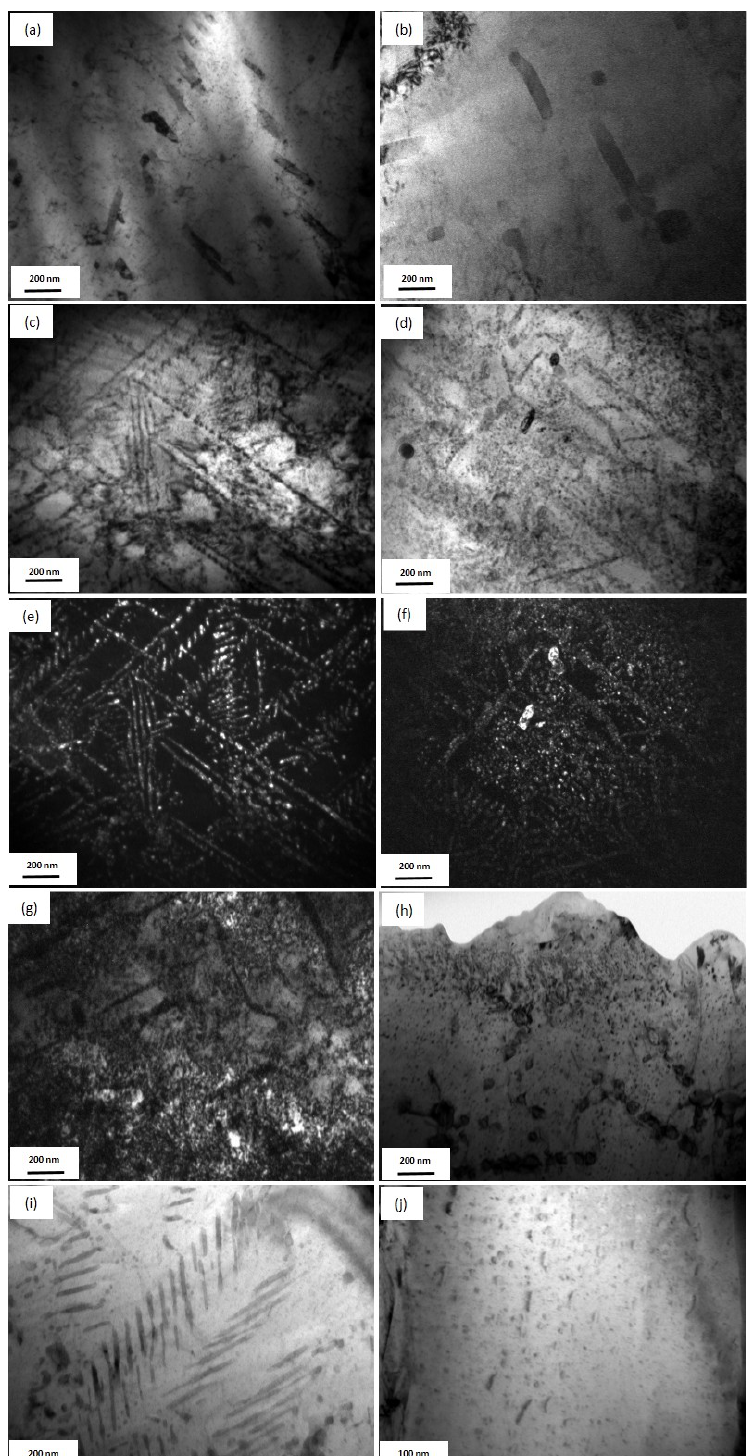
Figure 4. TEM images showing Ag precipitates in the Cu matrix at various temperatures for 4 h. Fe-free alloy: ( a ) as-solid-solution, ( c ) 450 °C and (e) dark field image of 450 °C, ( g ) 500 °C, ( i ) 550 °C; Fe-doping alloy: ( b ) as-solid-solution, ( d ) 450 °C and ( f ) dark field image of 450 °C, ( h ) 500 °C, ( j ) 550 °C .